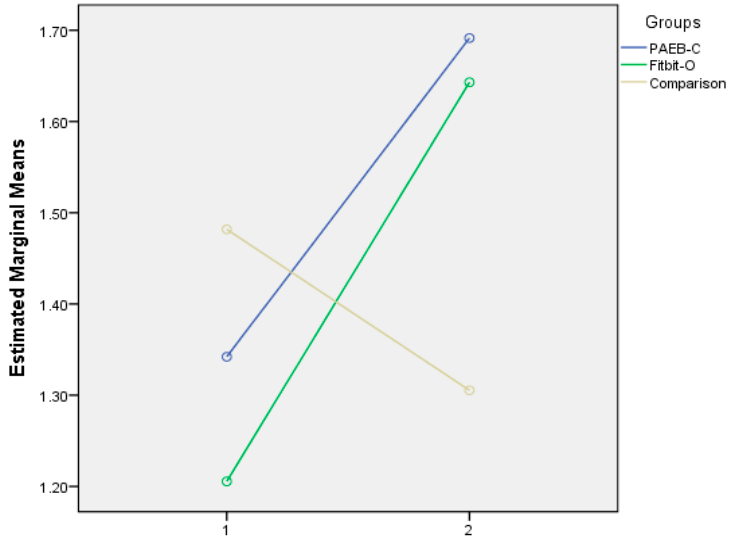
Figure 1. Mean scores of aerobic fitness among the three groups from pre- to post-test.